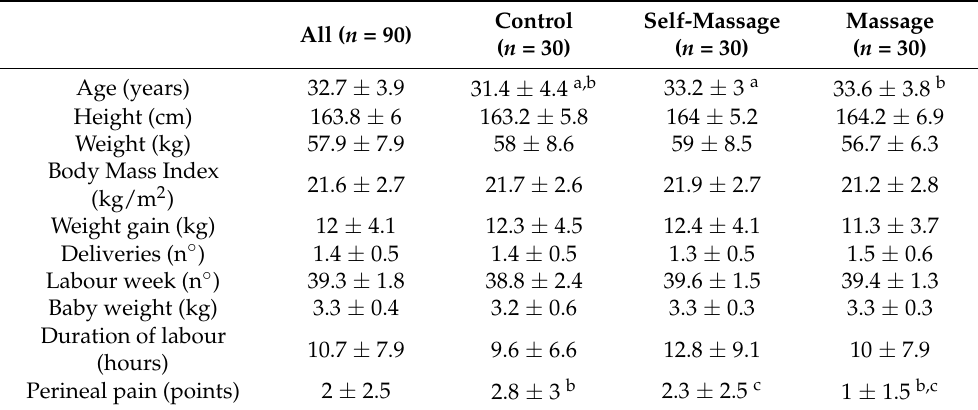
Table 1. Descriptive statistics of the sample (data provided: mean ± standard deviation). All ( n =